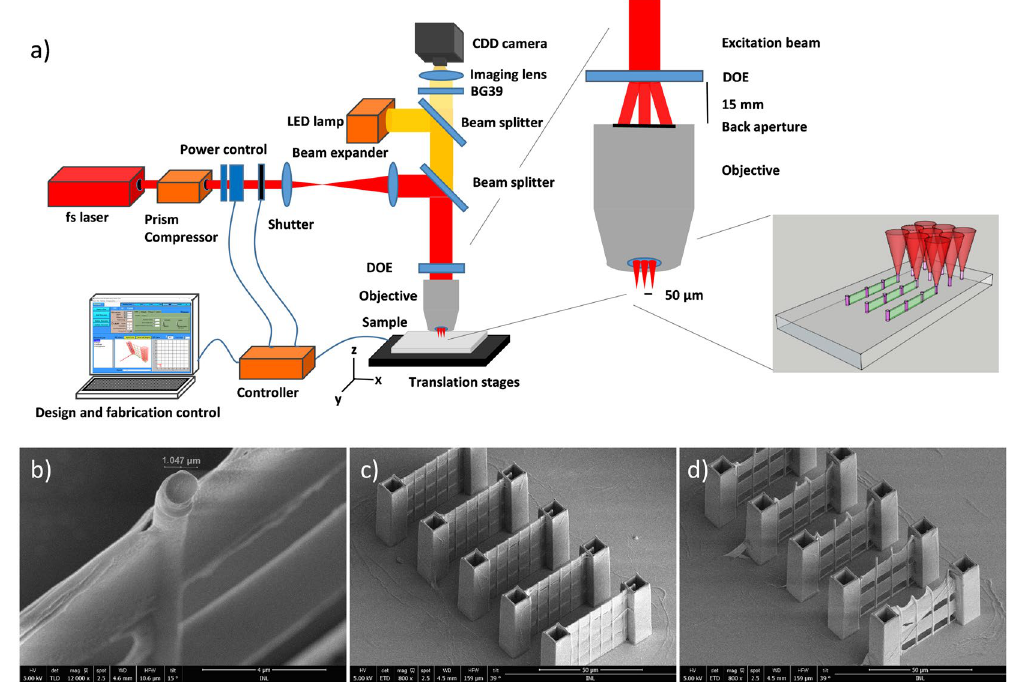
Figure 1. ( a ) Schematic representation of the TPP experimental setup based on a stage scanning system and a femtosecond laser; an enlarged cross section view of the beamlet-creating DOE and microscope objective as well as a 3D visualization of the parallelized writing using the 9 beamlets in the polymer. ( b ) SEM micrograph of a 3D structure detail, featuring a vertical line with a diameter of 1.047 µ m (Z-direction), the dimension in the XY-plane is indicating that the lateral voxel size is well below 1 µ m. ( c , d ) Study of voxel extend in the Z-direction. The horizontal line separation is changed from 7 µ m ( c ) to 10 µ m ( d ). For 7 µ m the wall is nearly intact, while for a separation of 10 µ m the wall becomes fully porous. We can estimate the voxel in Z-direction extension to be approx. 7 µ